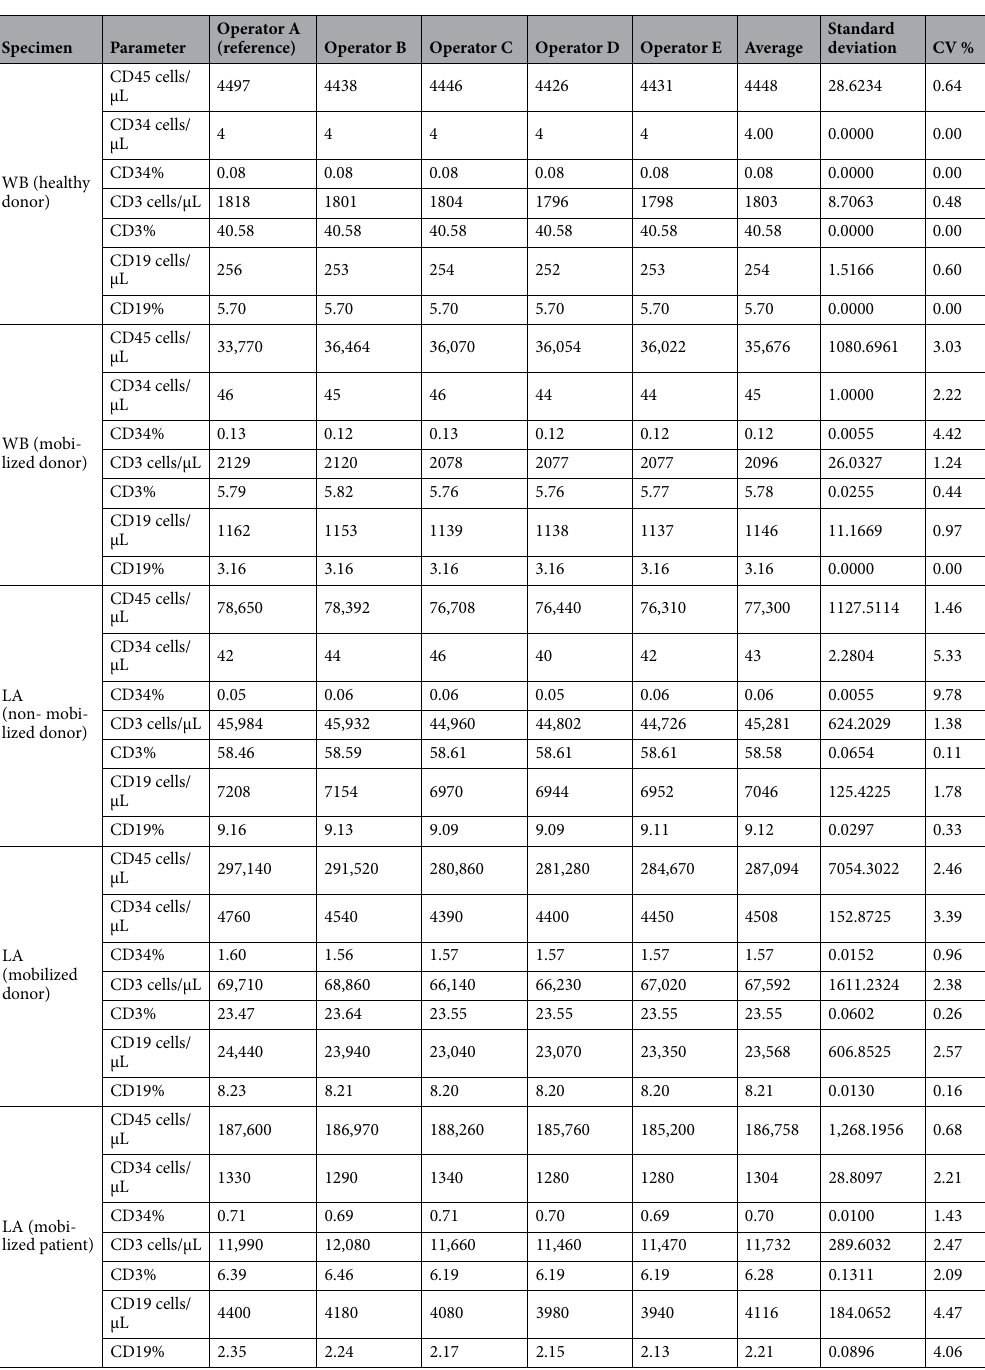
Table 4. Results of inter-operator analysis: operators (B to E) were checked versus the reference values of five several specimens analyzed with the pre-formulated dried reagent panel by Operator